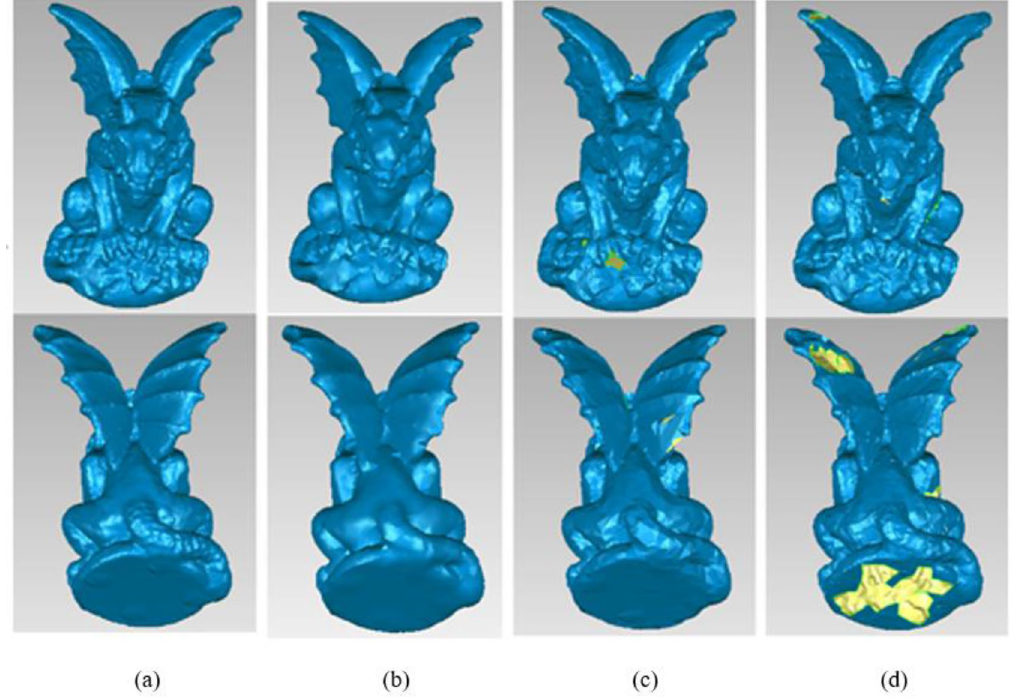
Figure 14. One of the reconstruction results of Gargo50k with different simplified methods. ( a ) Original data. ( b ) Our method. ( c ) The simplified method based on DFPSA. ( d ) The simplified method based on Gaussian spheres.